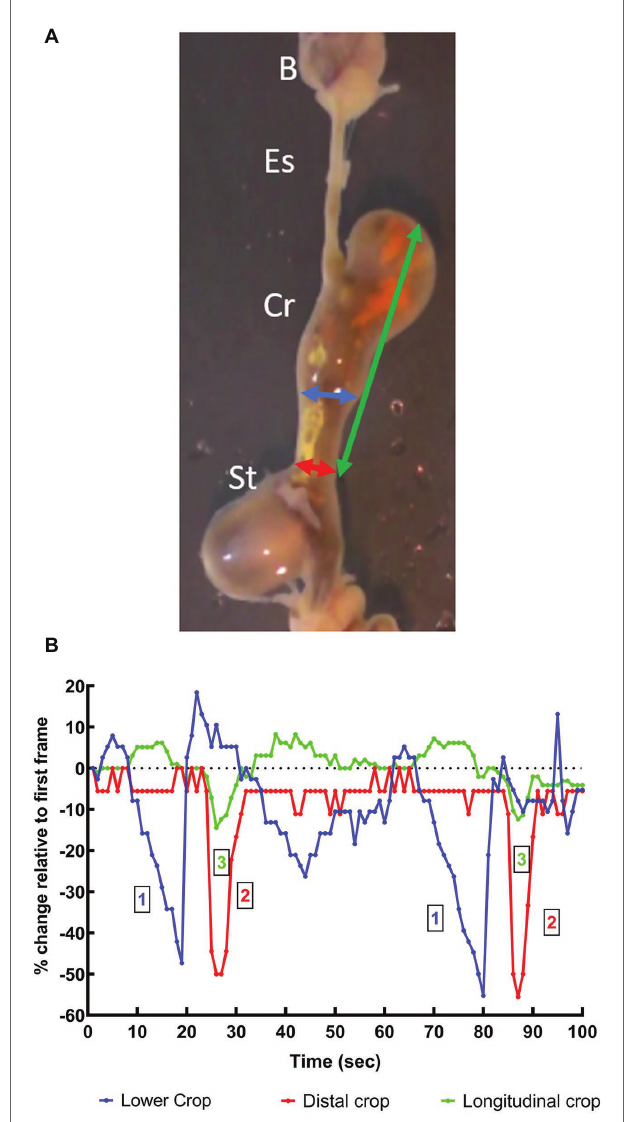
FIGURE 3 | (A) Video frame showing the beak, esophagus, crop, and stomach in vitro (see above text for details) from an O. vulgaris fed a crab 1 h before killing. The vertical axis of the frame is ~8 cm. Arrows indicate the measurements made of the apparent diameter of the lower crop (blue), distal crop (red) at the crop-stomach junction and the length of the crop (green). B, beak; Es, esophagus; Cr, crop; St, stomach. (B) Measurements of the changes in the dimensions of the crop made in vitro from an animal fed a crab 1 h before killing. The measurements defined above are made each second from 100 s of video recording (see Figure 2 ) and show two cycles of contraction. All measurements are expressed as a percentage change relative to those taken at t = 1 s. The two contractile cycles closely duplicate each other ~1 min apart. The graph shows the wave of contraction of the lower-crop (1) passes to the distal crop (2). The contraction of the distal crop is accompanied by longitudinal shortening of the crop (3). Note that both the lower and distal crop change apparent diameter by ~50% during the passage of the peristaltic contraction.